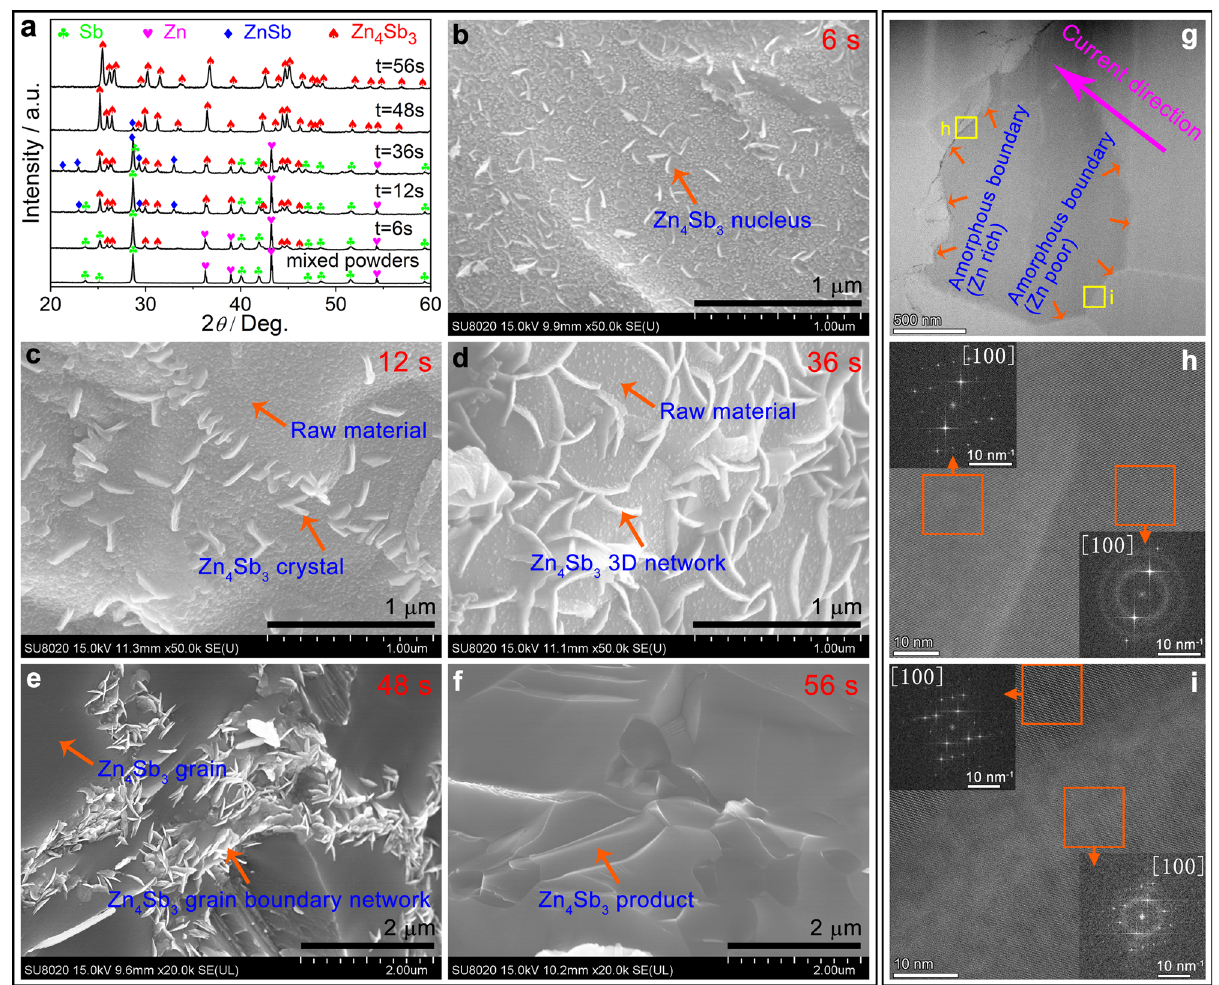
Fig. 2 Phase transformation and microstructure evolution during the ultra-rapid synthesis of β -Zn 4 Sb 3 bulk material. a Temporal evolution of the β -Zn β -Zn 4 Sb 3 phase formation; microstructure transformation process of 4 Sb 3 by FESEM: b 6 s, c 12 s, d 36 s, e 48 s, f 56 s. Fine microstructure of β -Zn 4 Sb 3 by TEM: g macroscopic image of grain, h macroscopic image of grain boundary located at the downstream side of the current, and the illustration is the diffraction pattern in the orange frame area, i macroscopic image of grain boundary located at the upstream side of current, and the illustration is the diffraction pattern in the orange frame